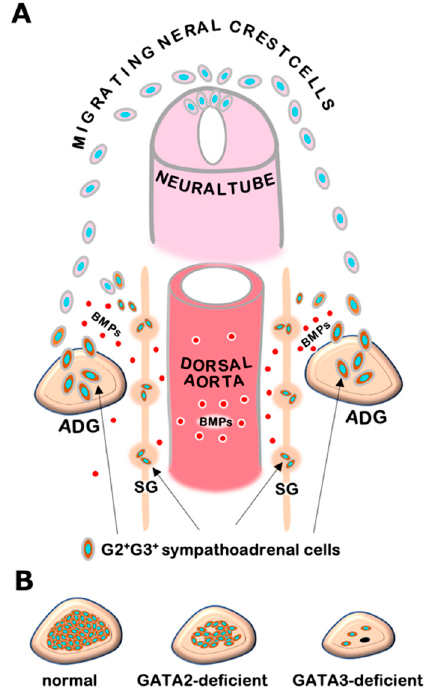
Figure 1. ( A ) Neural crest cells migrating from the dorsal neural tube undergo differentiation to sympathetic progenitor cells in response to bone morphogenetic proteins (BMPs) secreted from embryonic dorsal aorta. The sympathetic progenitors, which express GATA2 and GATA3, migrate to sympathetic ganglia (SG) and adrenal gland (ADG), and thereafter give rise to sympathetic neuronal cells and adrenal medullary chromaffin cells. ( B ) GATA3-deficient embryos show a significant decrease in adrenal chromaffin cells (right), while sympathoadrenal cell-specific GATA2-deficient embryos exhibit a modest decrease in chromaffin cells (middle) in comparison with normal adrenal gland in wild-type mice (left).